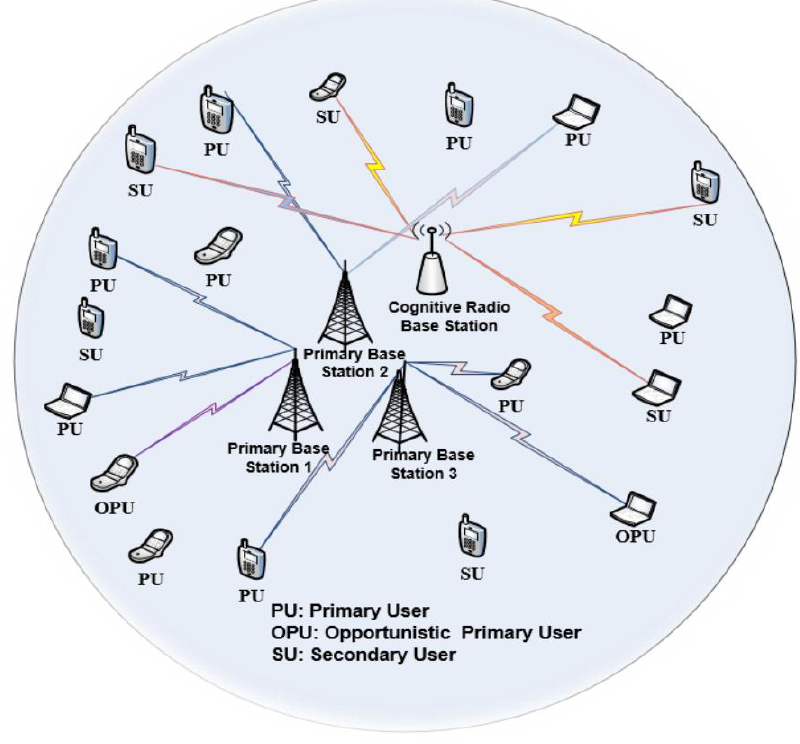
Figure 1. Primary and cognitive communications in collocated